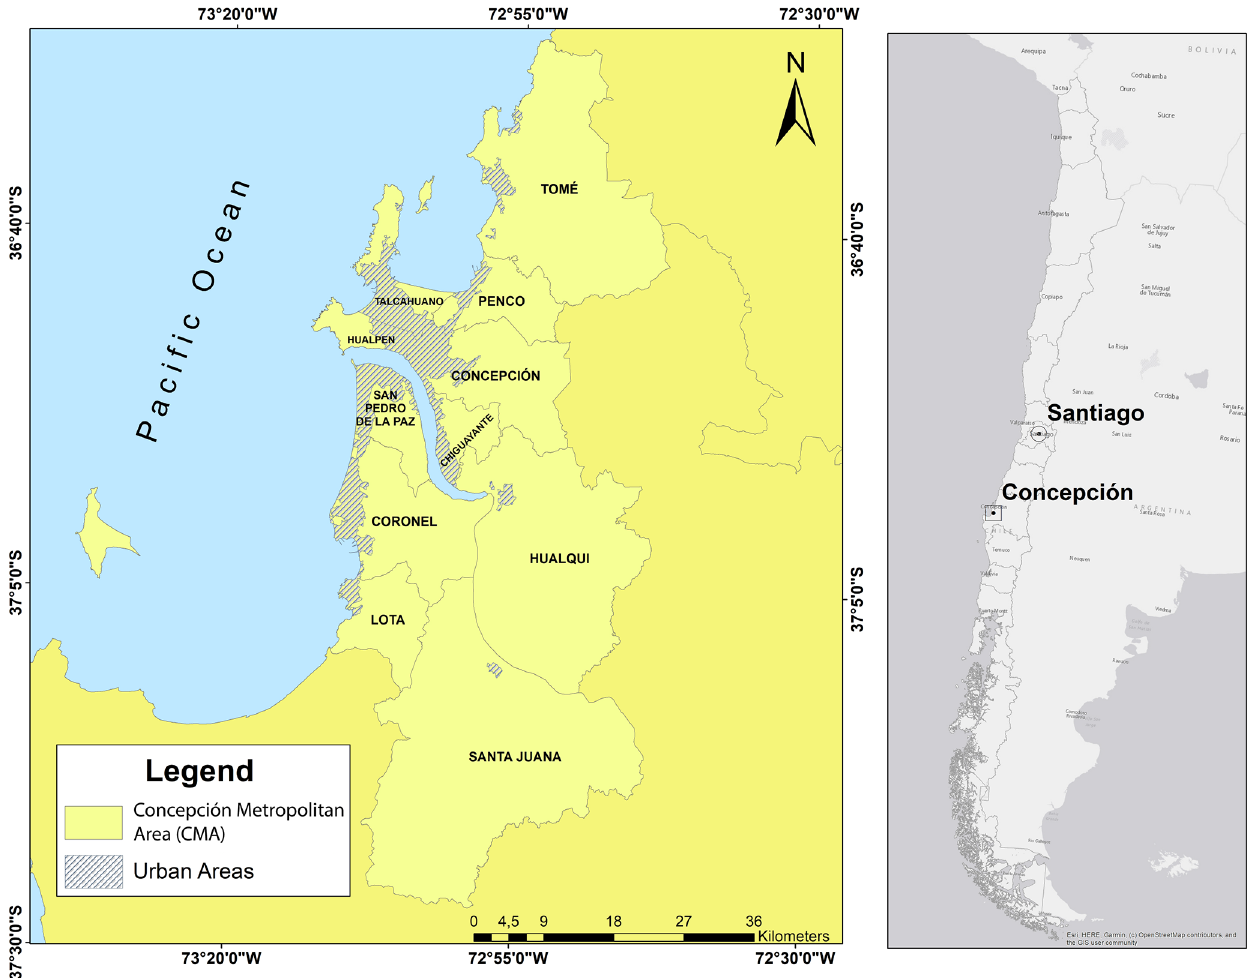
Figure 1. Map of the study area. The right map highlights Chile’s Biobío region in a continental context, and the CMA is shown on the left map. Source: CEDEUS (2016). © OpenStreetMap contributors 2021. Distributed under the Open Data Commons Open Database License (ODbL)